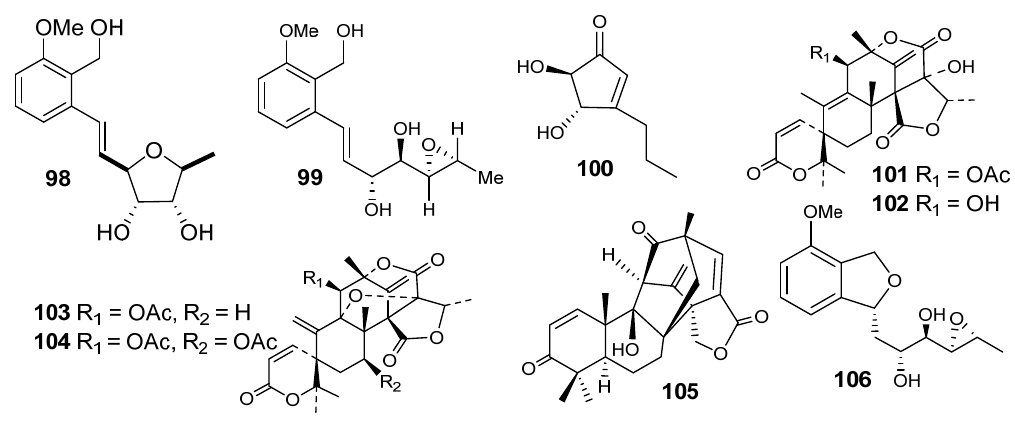
Figure 6. Structures of compounds 98–106.